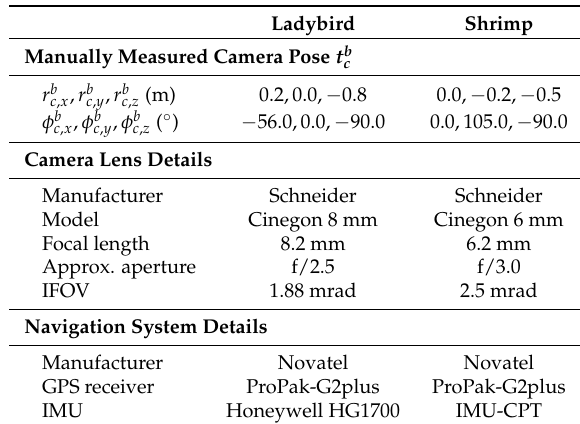
Figure 3. The Ladybird ( a ) and Shrimp ( b ) robotic platforms and sensor configurations. Table 1. Platform